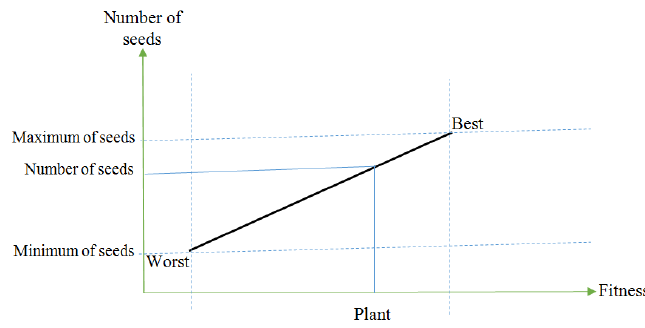
Figure 3. the relation of fitness with number of seeds